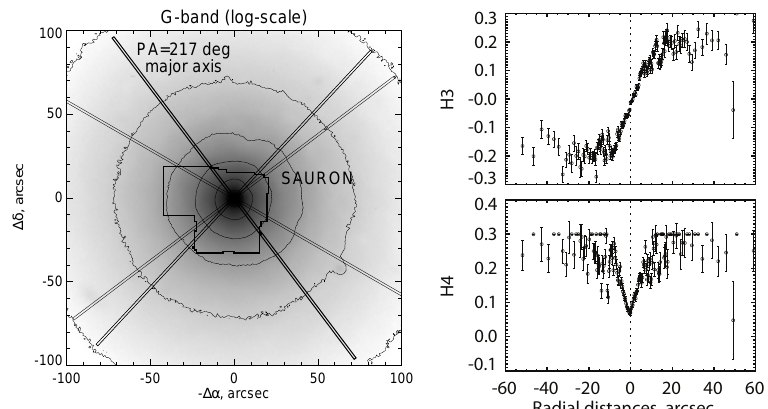
Fig. 1. Left panel. The positions of the SCORPIO slits and the SAURON mosaic field of view are overlapped onto the g -band image of NGC 524 obtained with CFHT. Right panel. The Gauss-Hermite coefficients characterizing the asymmetry of the stellar